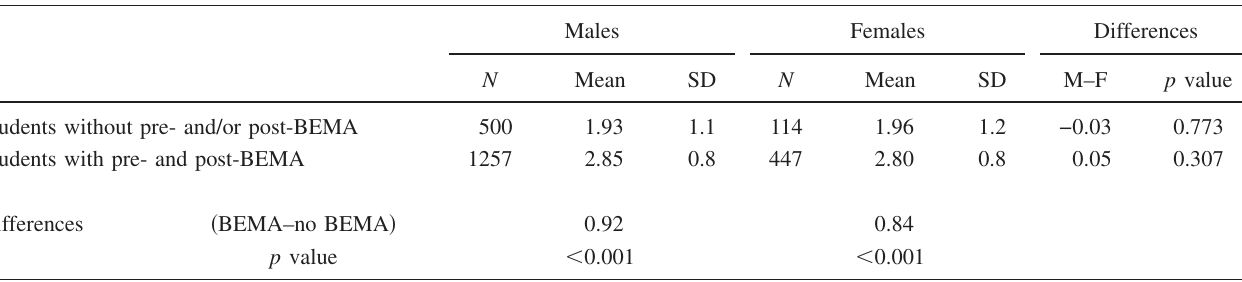
TABLE II. Average course grades for males and females who did and did not take the BEMA. Course grades are on a 0.0–4.0